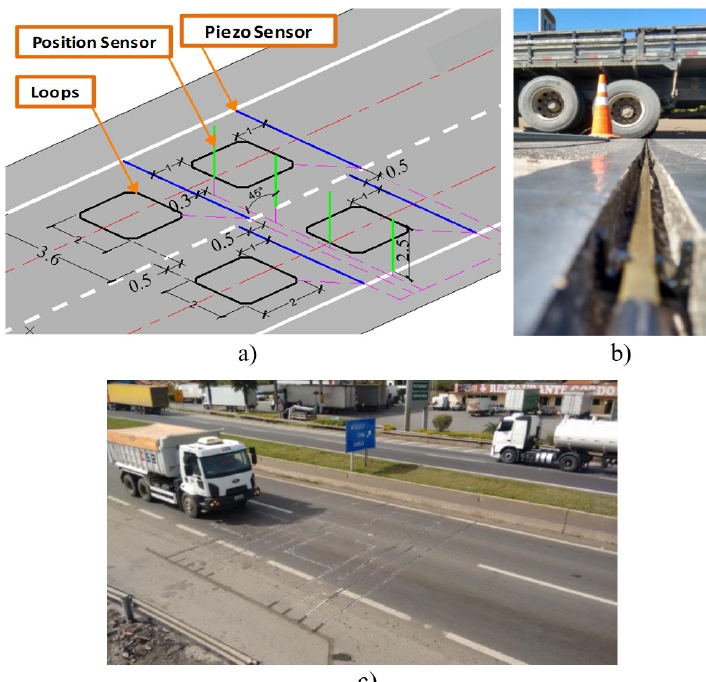
Figure 3. HS-WIM system: a) layout and sensors position [4], [5]; b) weighting sensor before grout in BR-381 [4], [5], [33]; c) final appearance of the pavement in BR-381 [5], [33] (position sensors, which detect when vehicles change lanes, was not installed).